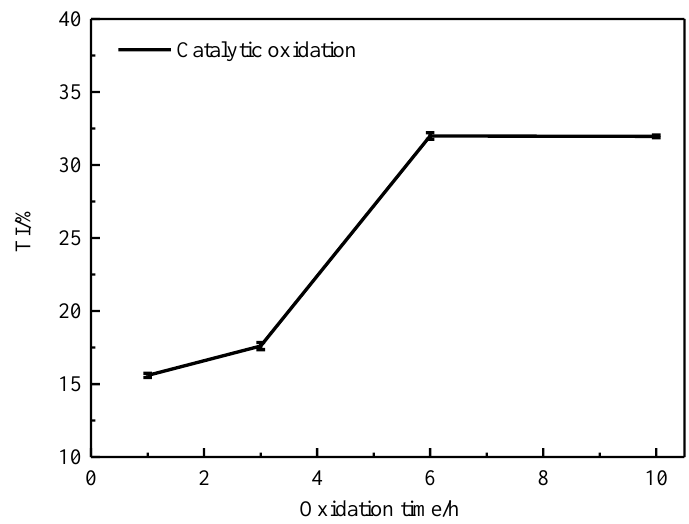
Figure 2. Change of TI content in CTP with catalytic oxidation time.